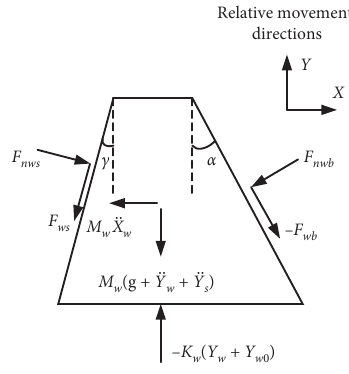
Figure 5: Mechanical model of the wedge.